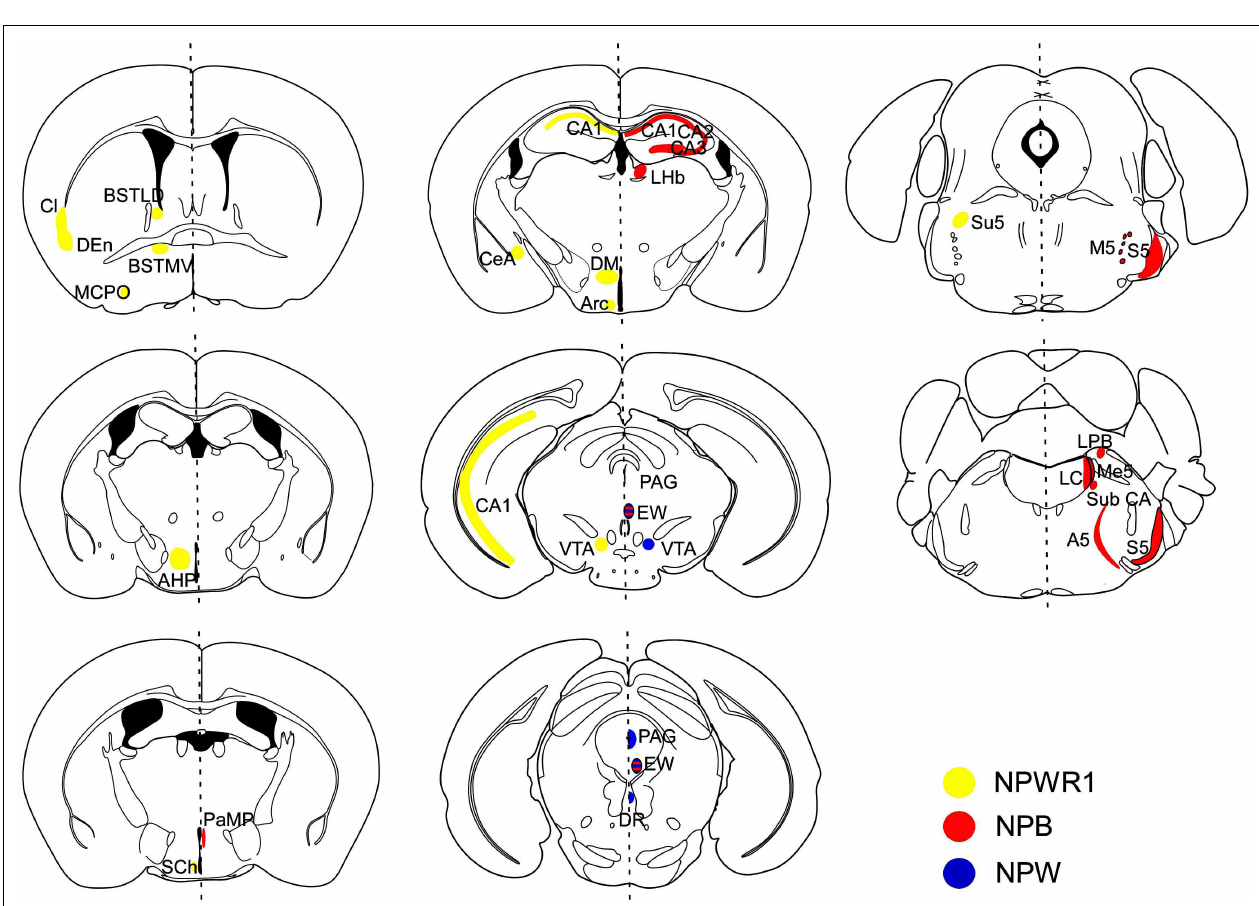
matter, EW nucleus (EW), ventral tegmental area (VTA), and dorsal raphe nucleus (DR). NPBWR1 mRNA (yellow regions) was observed in the claustrum (Cl), dorsal endopiriform nucleus (DEn), bed nucleus of the stria terminals, laterodorsal part (BSTLD), bed nucleus of the stria terminalis, medioventral part (BSTMV), suprachiasmatic nucleus (Sch), magnocellular preoptic nucleus (MCPO), paraventricular hypothalamic nucleus, posterior part (PaPo), dorsomedial hypothalamic nucleus (DM), central amygdala (CeA), CA1 field, hippocampus (CA1), ventral tegmental area (VTA), sensory root trigeminal nerve (Su5), subiculum (S), anterior hypothalamic area, posterior part (AHP), and arcuate hypothalamic nucleus (Arc). Modified from Hondo et al.